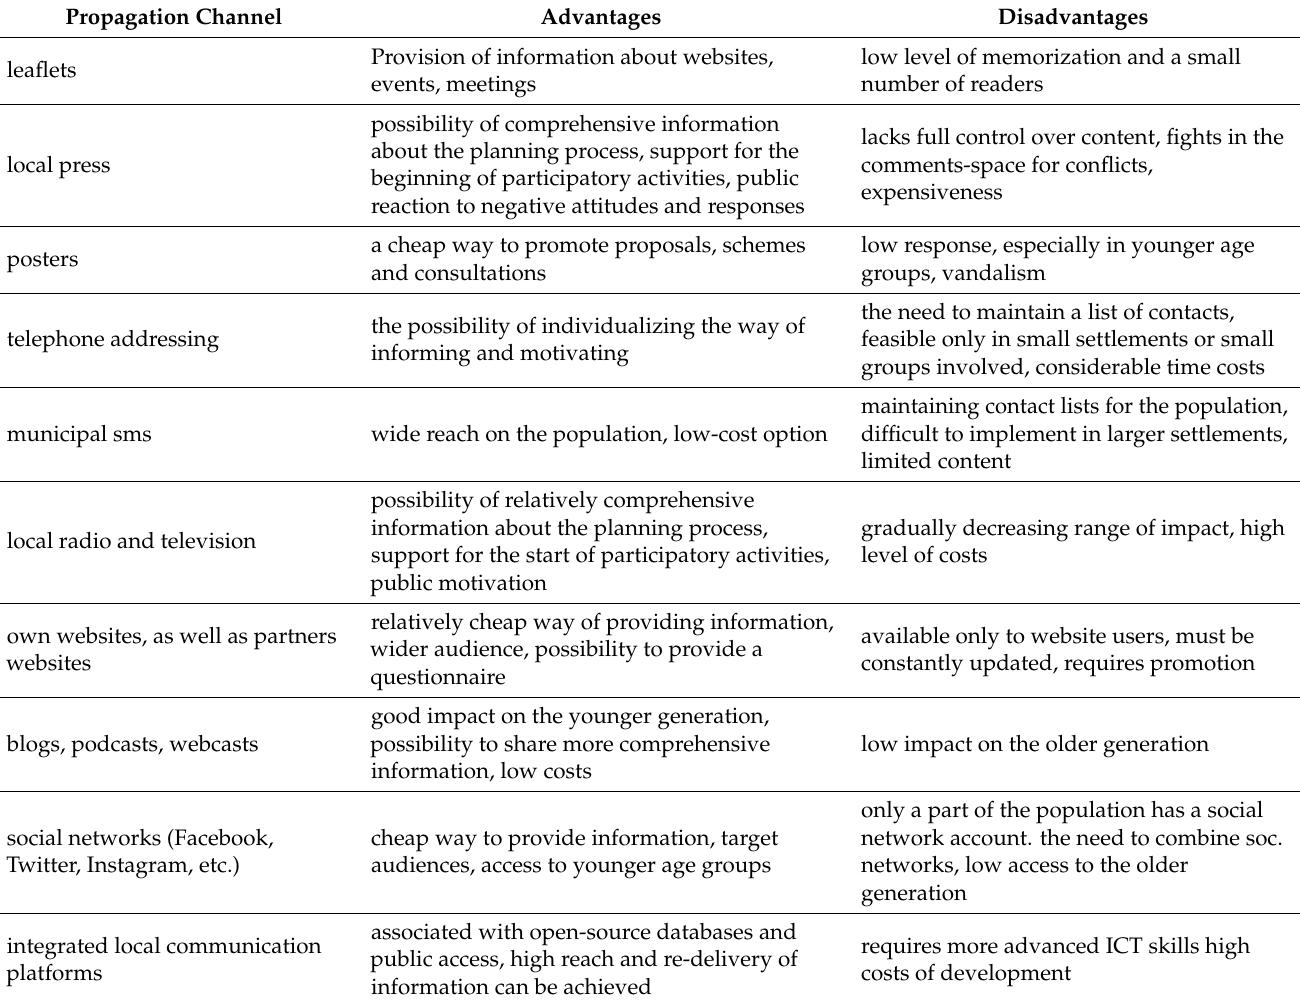
Table 5. Overview of communication tools for ensuring